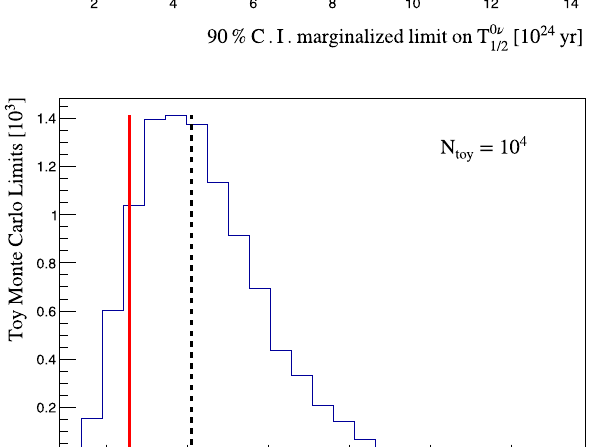
terior pdfs for individual background parameters in Fig. 5 ( 0 νββ) and Fig. 6 ( 2 νββ) . Their means agree with the corre- sponding results from blinded data within one standard devi- ation. We observe a slight negative background fluctuation (i.e. limit stronger than expected) in the 0 νββ decay analysis and a positive one (i.e. limit looser than expected) in the 2 νββ decay analysis with respect to the median 90% C.I. limit.